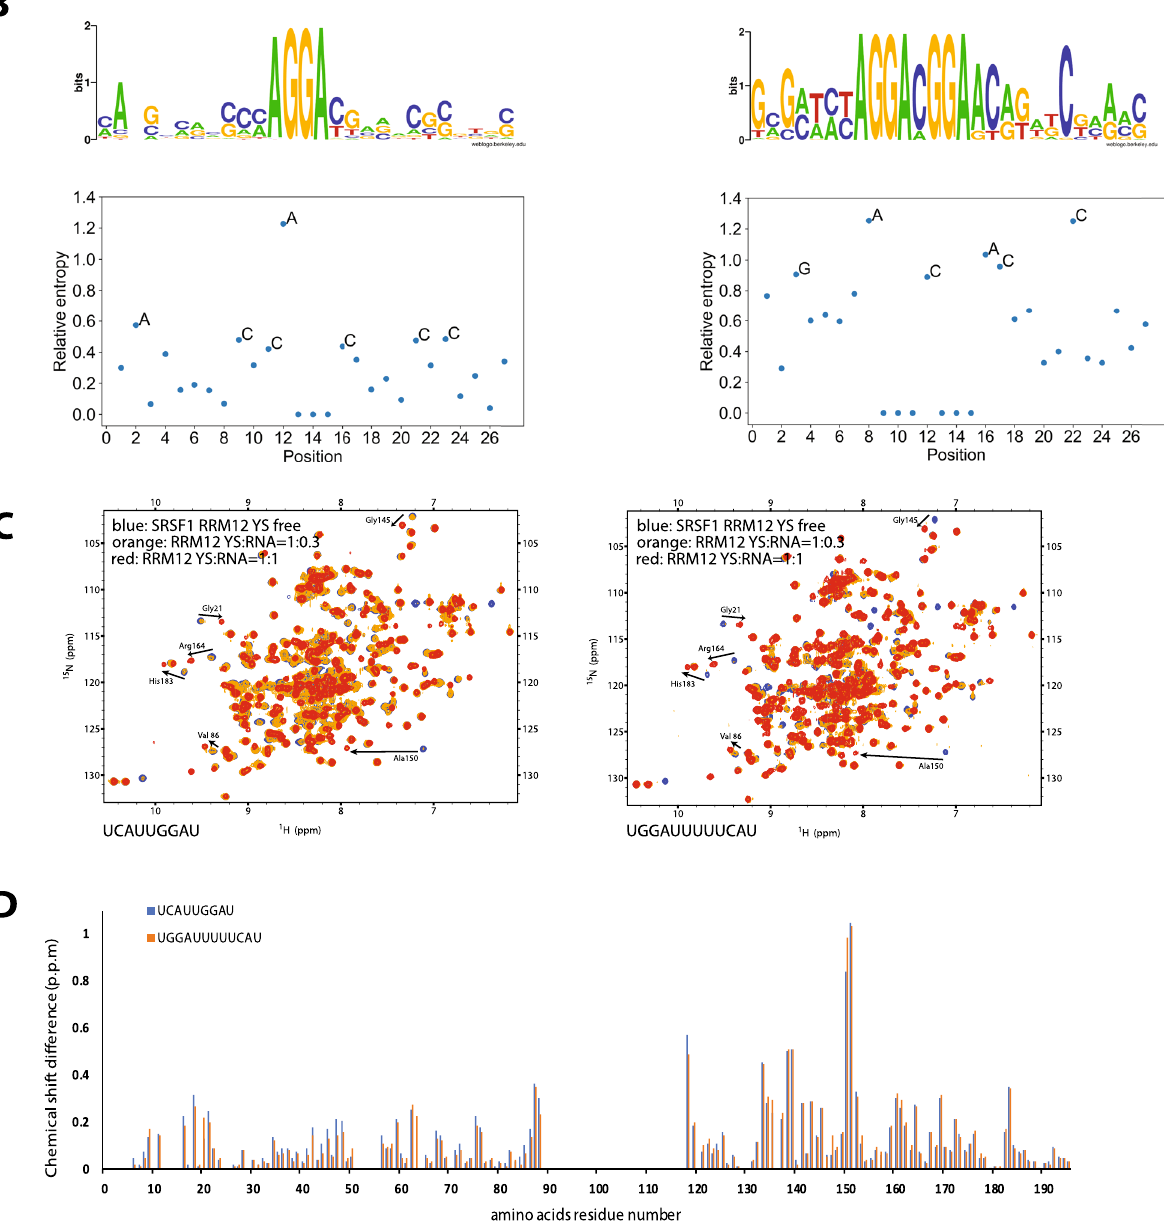
Fig. 4 SRSF1 RRM1 interacts with RNA on both sides of RRM2-binding site. A Schematic representation of the RNA molecules used for the SELEX experiment. Invariant GGA nucleotides were inserted in the middle of the degenerated sequence to recruit SRSF1 RRM2 and allow the selection of potential RRM1 binding sites on both sides of the motif. B The sequences selected by SELEX with SRSF1 RRM12 followed two main patterns containing either the GGA or a GGANGGA motif. To determine the positions with the most stringent selection during SELEX, we calculated the relative entropy of position- dependent nucleotide frequency distributions of foreground and background sequences (lower panels). C Overlay of 1 H- 15 N HSQC spectra measured with SRSF1 RRM1 + 2 YS free form and in the presence of UCAUUGGAU or UGGAUUUUUCAU RNA at 0.3:1 and 1:1 RNA:protein ratios (in blue, orange, and red, respectively). D Mapping of the chemical-shift perturbations observed upon interaction of SRSF1 RRM1 + 2 YS with the two RNAs tested in C . SRSF1 RRM1 binds equally well the cytosine located at − 4 or + 6 from the GGA